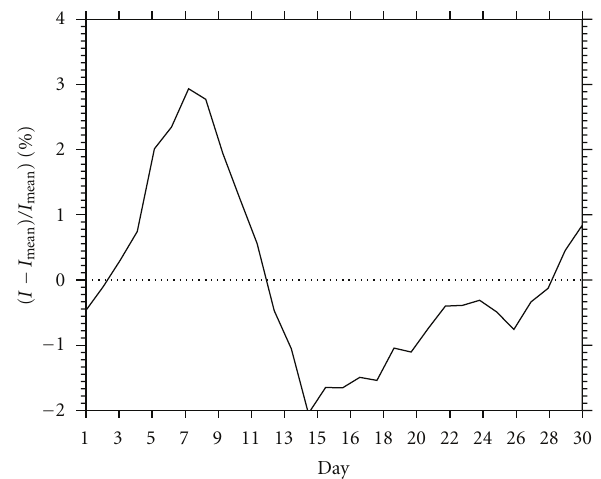
Figure 1: Deviation of the solar irradiance at 205nm from its monthly mean for January 1992. The data are from SUSIM instru- ment onboard UARS